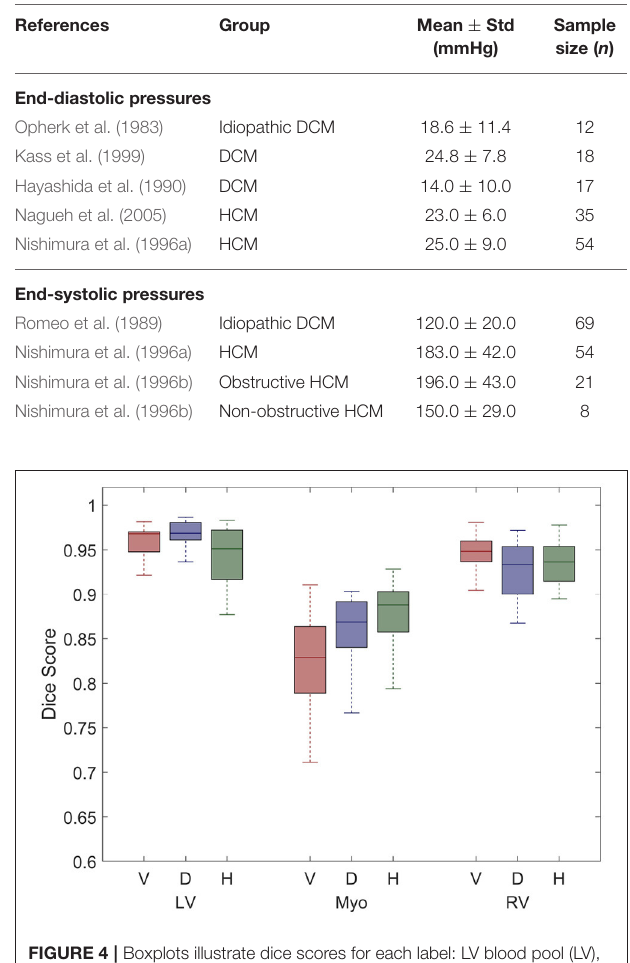
FIGURE 4 | Boxplots illustrate dice scores for each label: LV blood pool (LV), LV myocardium (Myo), and RV blood pool are shown for the healthy volunteers (V), DCM patients (D), and HCM patients (H). The centre line of each boxplot represents the median and the whiskers denote the 25th and 75th